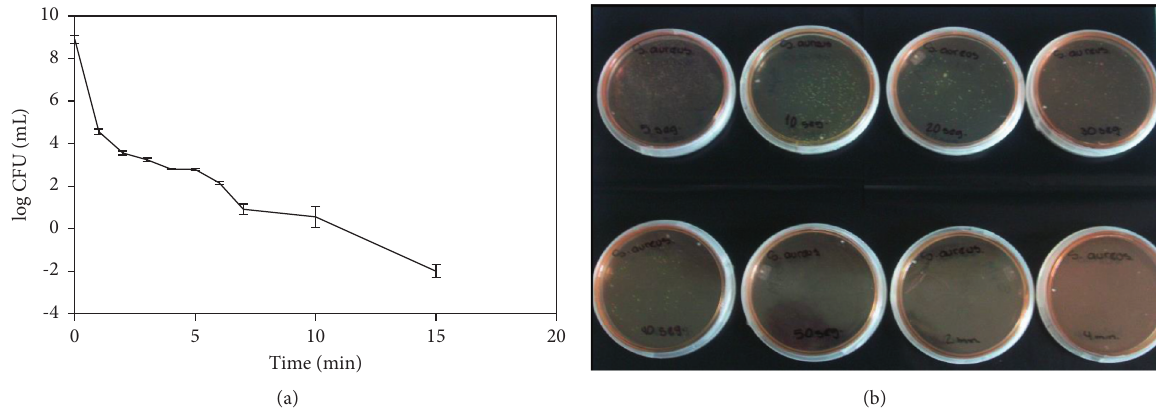
Figure 3: Biomass reduction. (a) Death kinetics of Staphylococcus aureus ATCC 6538; (b) Staphylococcus aureus ATCC 6538 cells in Petri